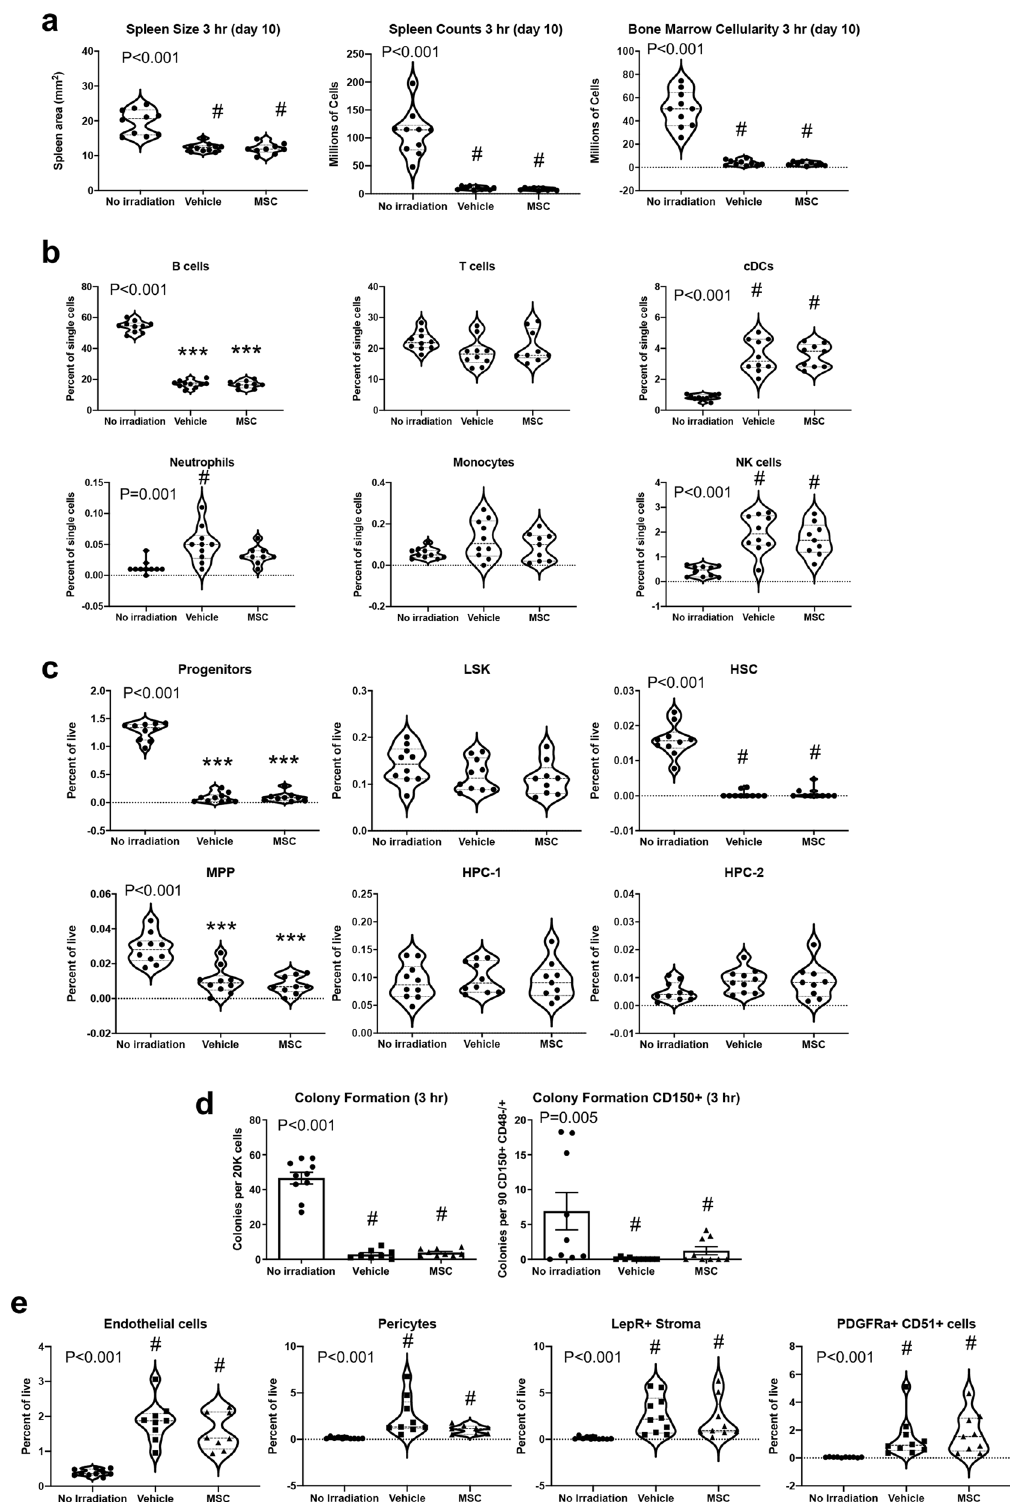
Figure 6. Administration of MSC therapy 3 h after radiation produces outcomes similar to 30 h infusion. Measurement of ( a ) spleen size and cellularity, ( b ) immune lineages in the spleen, ( c ) HSPC frequencies, ( d ) colony formation activity of whole bone marrow or sorted CD150 + cells, and ( e ) niche cell populations in the bone marrow. Statistical significance of differences between groups is depicted on the graphs. Posthoc comparisons are demarcated by asterisks *** P < 0.001 for Holm–Sidak (One-way ANOVA) or pound symbol # P < 0.5 for Dunn’s (Kruskal–Wallis One-way ANOVA) analyses relative to No irradiation